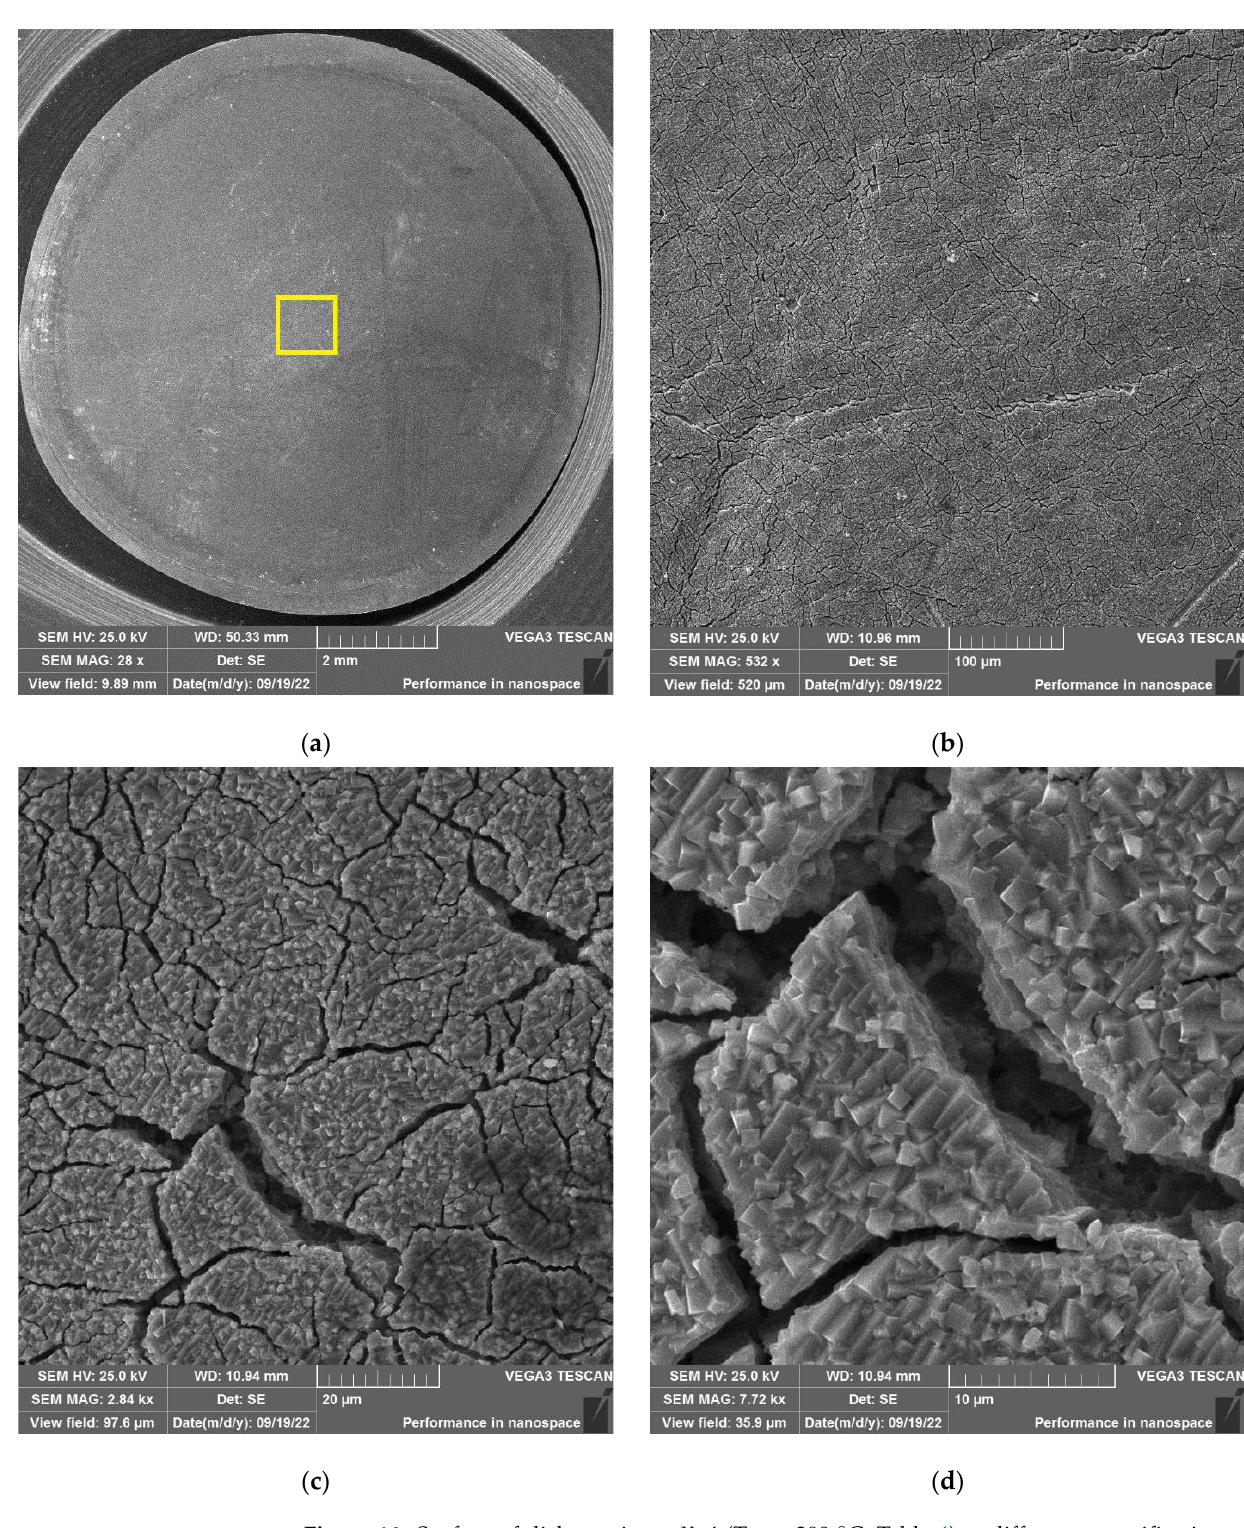
Figure 16. Surface of disk specimen № 4 (T irr = 390 °C, Table 4) at different magnifications after autoclave SCC tests with a load value of 605 N and additional loading up to 6023 N.